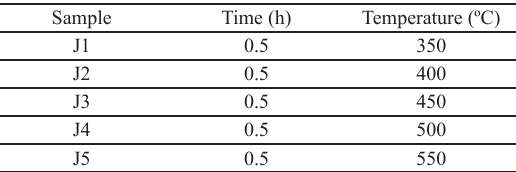
Table 4. Time and temperature parameters for oxidation of the second film. Sample